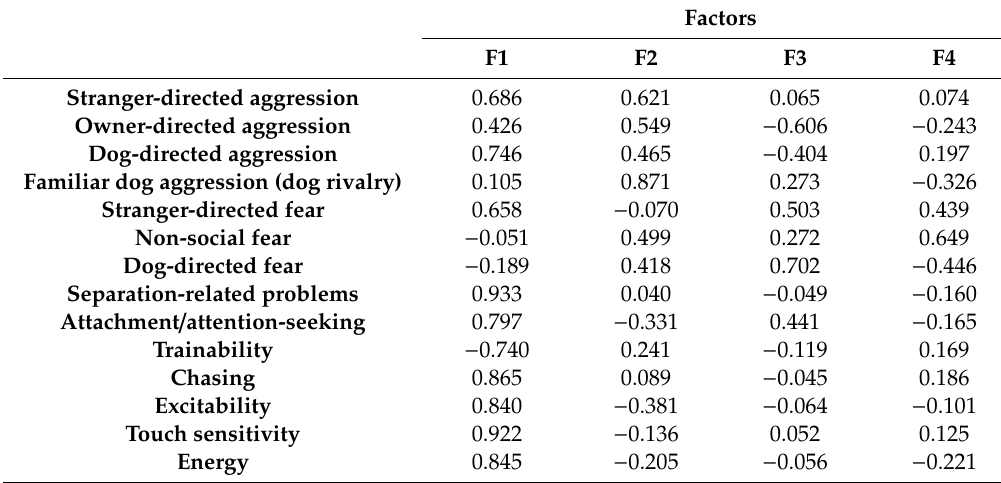
Table 3. Results from the principal component analysis (PCA): factors and relevant correlations with behavioural categories (highlighted in